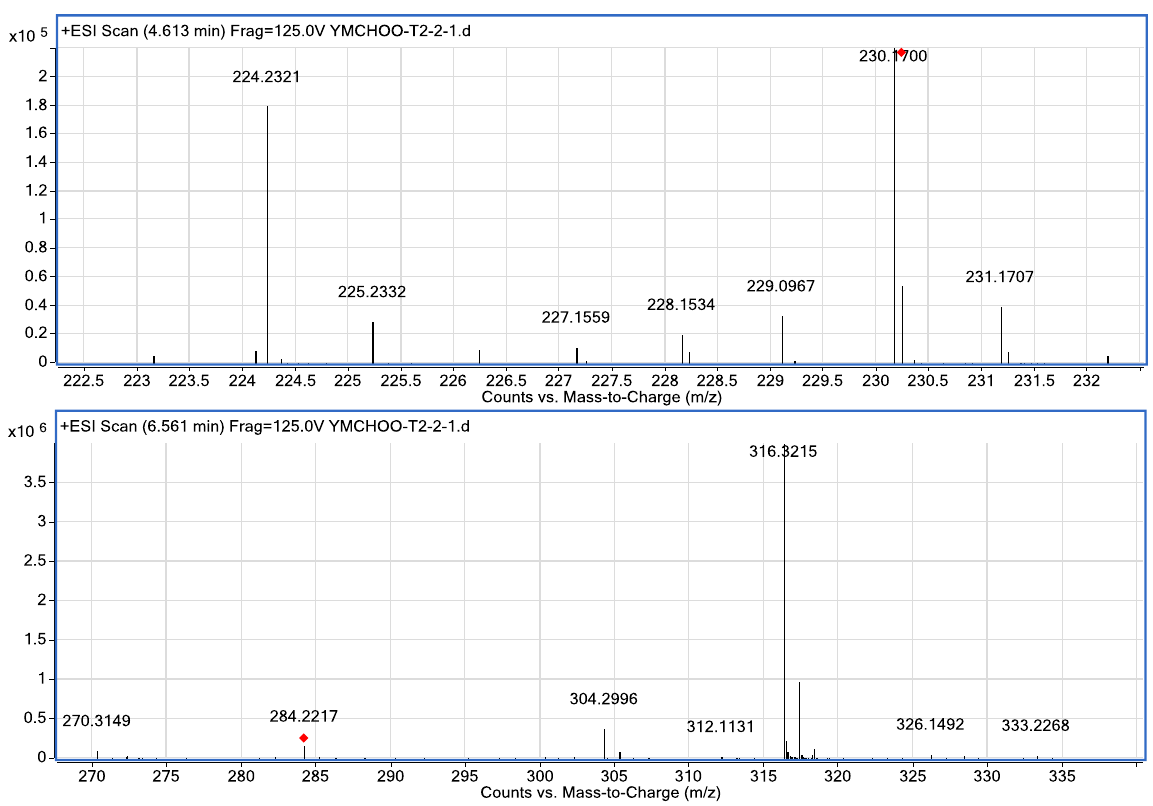
Figure 4. Mass spectrometry analysis of spent supernatants extract P. putida strain T2-2 Upper panel : mass spectra ofC8-HSL ( m/z 228.1534) (marked by arrow), lower panel : C12-HSL ( m/z 284.2217) (marked by